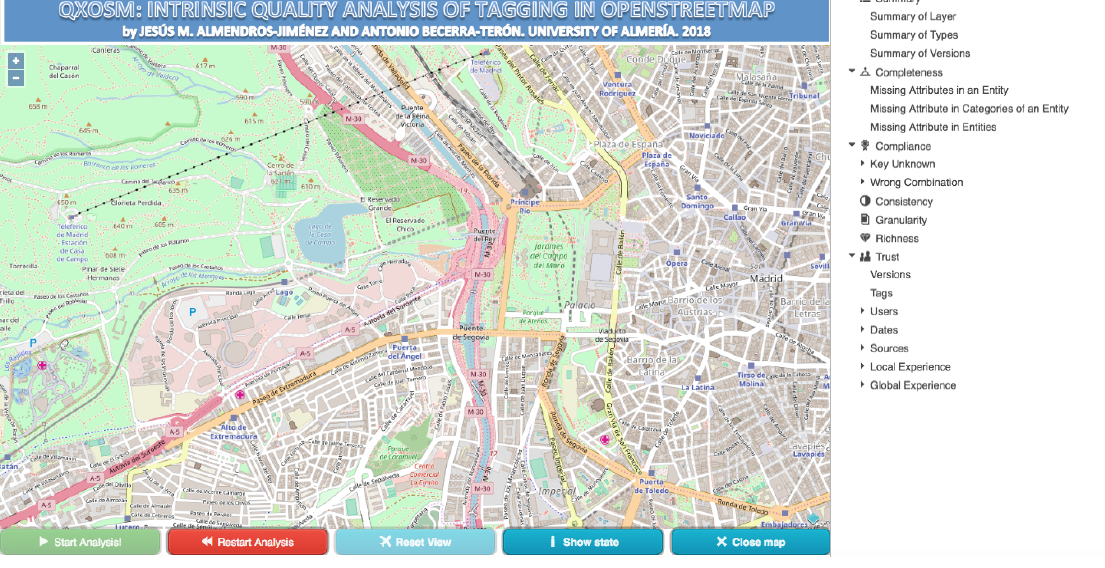
Figure 31. Main window of the Web